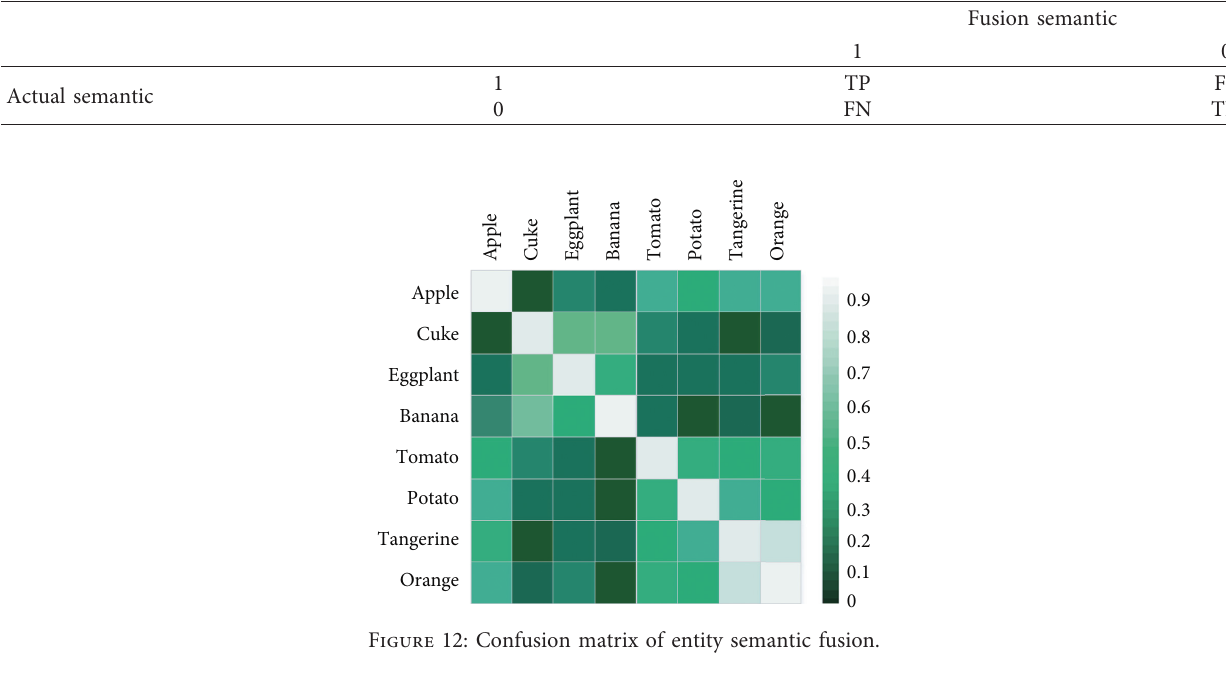
Table 3: Meaning of TP, TN, FP, and FN.